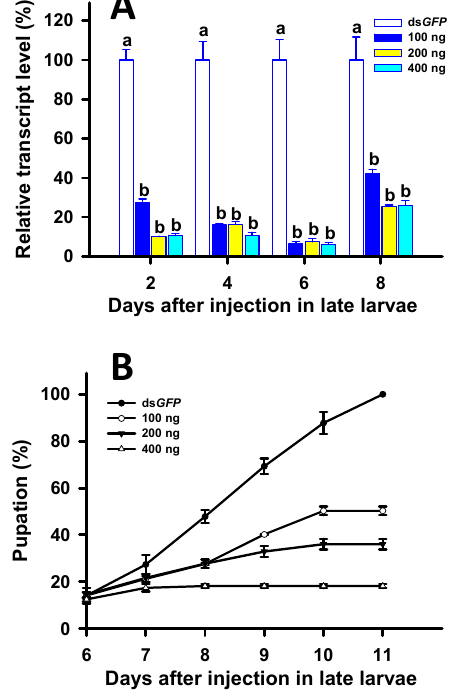
Figure 6. Time-dependent suppression of TcLgl transcript in late (20-day) larvae of T. castaneum injected with ds TcLgl at 100, 200, and 400 ng/larva or ds GFP at 400